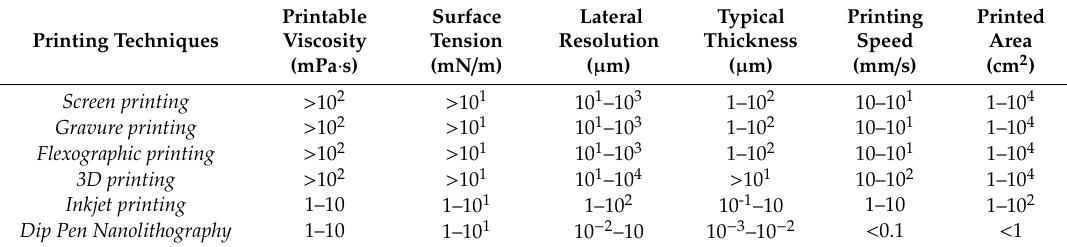
Table 1. Main features of the printing methods relevant for ZnO-based inks printing reported in this